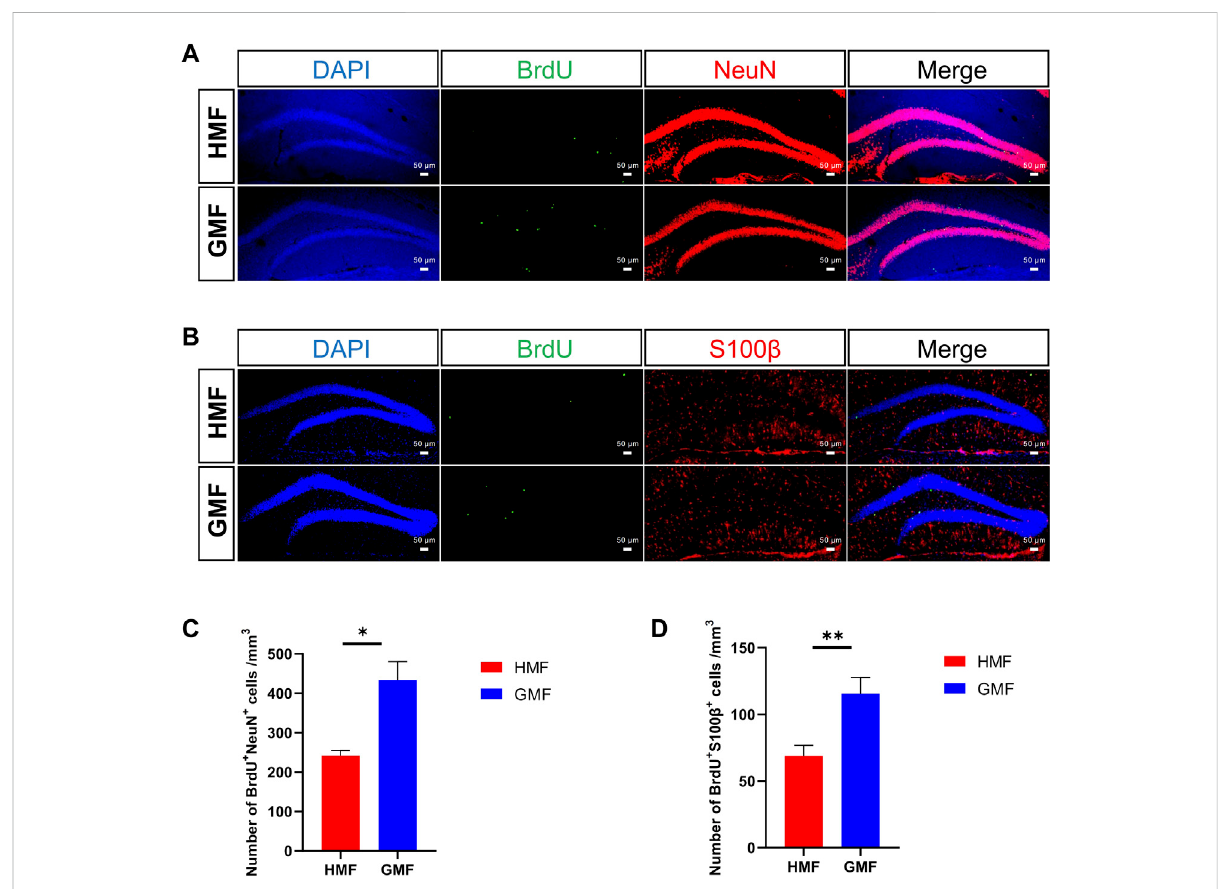
FIGURE 4 Long-term hypomagnetic fi eld (HMF) exposure decreased the neuronal and astrocytic differentiation of aNSCs in DG of hippocampus. (A) Representative images of BrdU + NeuN + cells (newborn neurons) in the DG after 12-week of GMF- or HMF-exposure. (B) Representative images of BrdU + S100 β + cells (newborn astrocytes) in the DG after 12-week of GMF- or HMF-exposure. (C) Quanti fi cation of numbers of BrdU + NeuN + cells in GMF- and HMF-exposed mice ( p = 0.022). (D) Quanti fi cation of numbers of BrdU + S100 β + cells in GMF- and HMF-exposed mice ( p = 0.0016). There were 4 mice in each group. Data are expressed as mean ± SEM. * p < 0.05; ** p < 0.01. GMF means geomagnetic fi